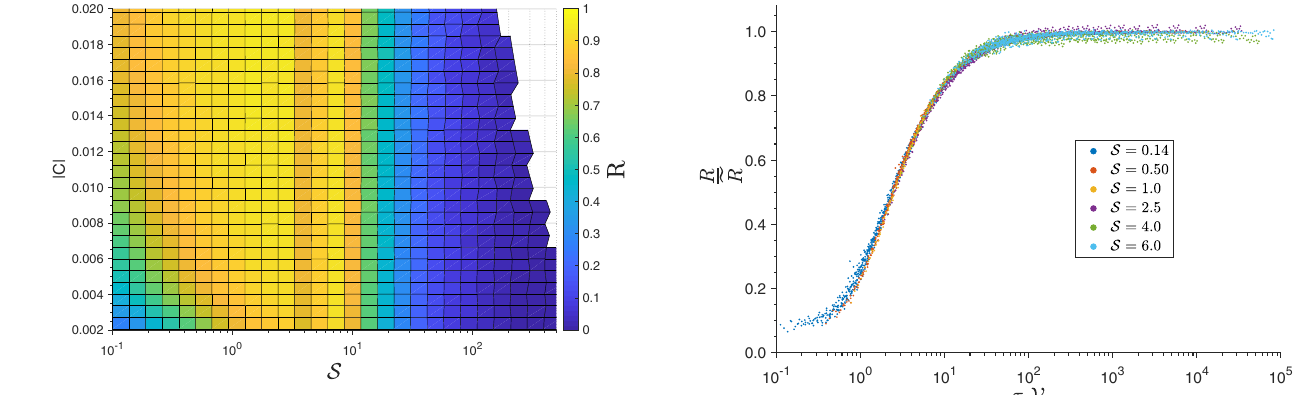
FIG. 6. Quality of emittance exchange as a function of the scaling parameter for the SLS booster lattice including radiative FIG. 8. Deterioration of the emittance exchange due to radi- ¼ 2 . 1 j C j . effects. Extraction happens for Δ ext ation damping as a function of τ x V =A . R is divided by undamped emittance exchange